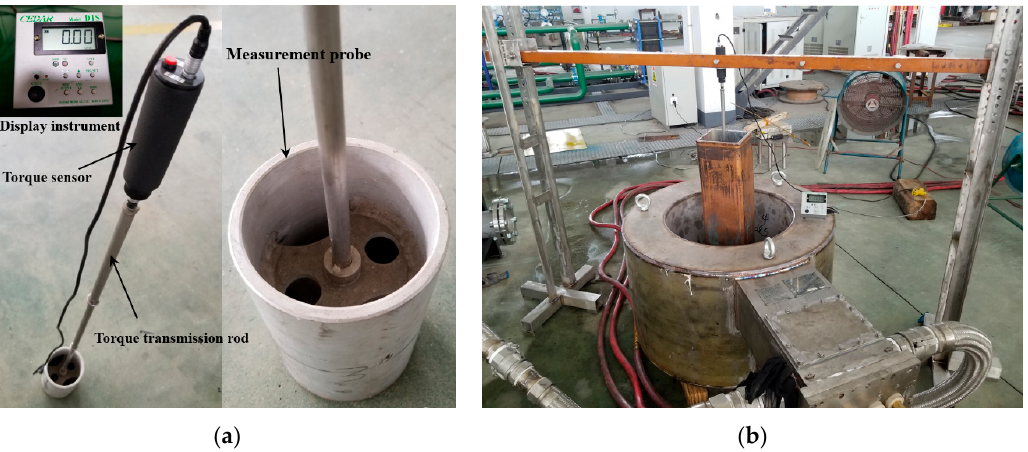
Figure 3. Structure photo of the electromagnetic torque measurement device: ( a ) torque meter; ( b ) offline test equipment.